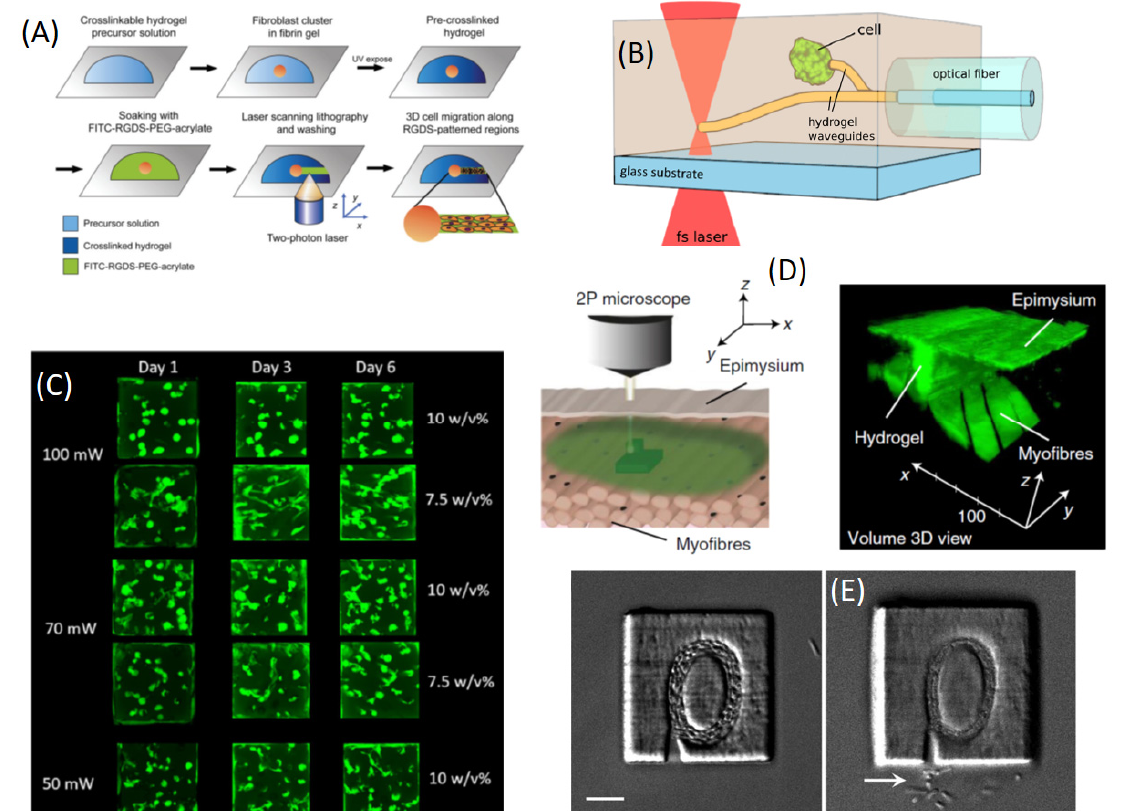
Figure 10. ( A ): The overall methodology for three-dimensional RGDS patterning by TPL: (1) HDFs encapsulated in fibrin clusters are photo-polymerized into collagenase-sensitive PEG hydrogels (385 nm light), (2) hydrogels are soaked in PEG– RGDS solution; (3) TPL is used to pattern RGD rich regions in the hydrogels; (4) after washing, cell migration is monitored over time. Reprinted from [124]. ( B ): Schematic illustration showing the cross-linking process in a cell-loaded hydrogel with a waveguide starting from a fiber connecting a cell for fluorescent excitation. Reprinted from [125]. ( C ): LSM images of 200 × 200 × 200 µ m 3 RCPhC1-NB/SH-based cubes printed in the presence of living ASC–GFPs using 2 mol % DAS with respect to the photo-cross-linkable functionalities (left). The cubes were printed using different concentrations and laser powers. Reprinted with permission from [129]. ( D ): Schematic showing two-photon cross-linking of HCC–hydrogel into skeletal muscle across epimysium (left). Right panel: representative 3D volume reconstruction of 6 independent replicates showing HCC–8-arm PEG structure ( ∆ z = 300 µ m) manufactured between undamaged myofibers and epimysium of skeletal muscle in GFP+ mice; coordinates and 50 µ m scale bar are shown. From [130]. Panel ( E ): Differential interference contrast image of E. coli cells densely packed into an o-shaped chamber after several cell divisions. Abrupt change in bath pH (7 to 12.2) causes temporary compression of the chamber and the release of a few cells (arrow). (Scale bars, 5 μm ). Reprinted with permission from [131].